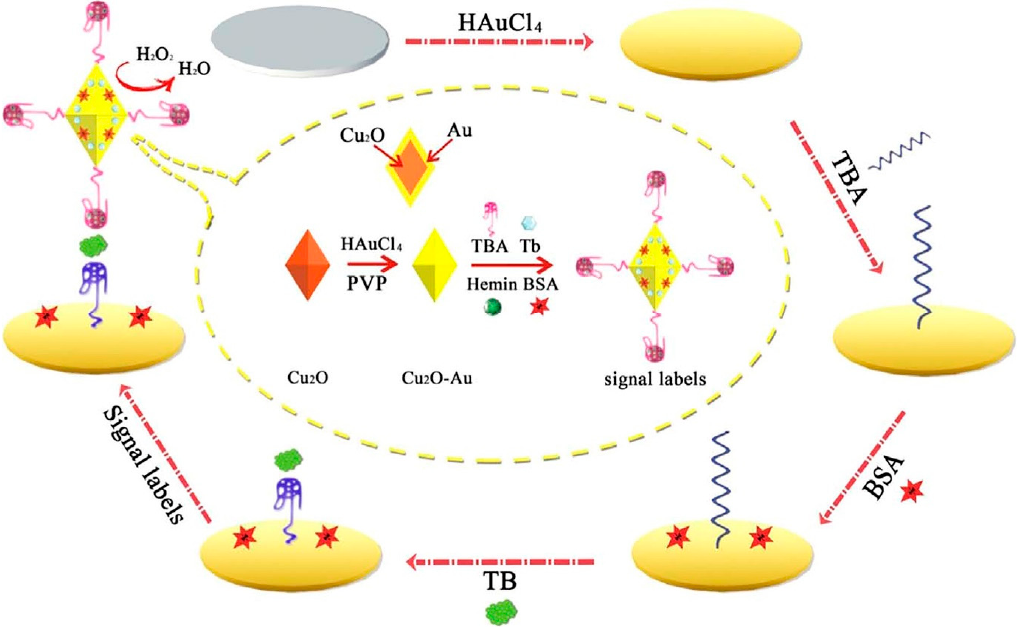
Figure 5. The signal amplification strategy for a chronoamperometry-electrochemical aptasensor for the determination of TB based on the use of AuNP functionalized octahedral Cu 2 O nanocrystals and hemin/G-quadruplex tagged Cu 2 O-Au-BSA [70].